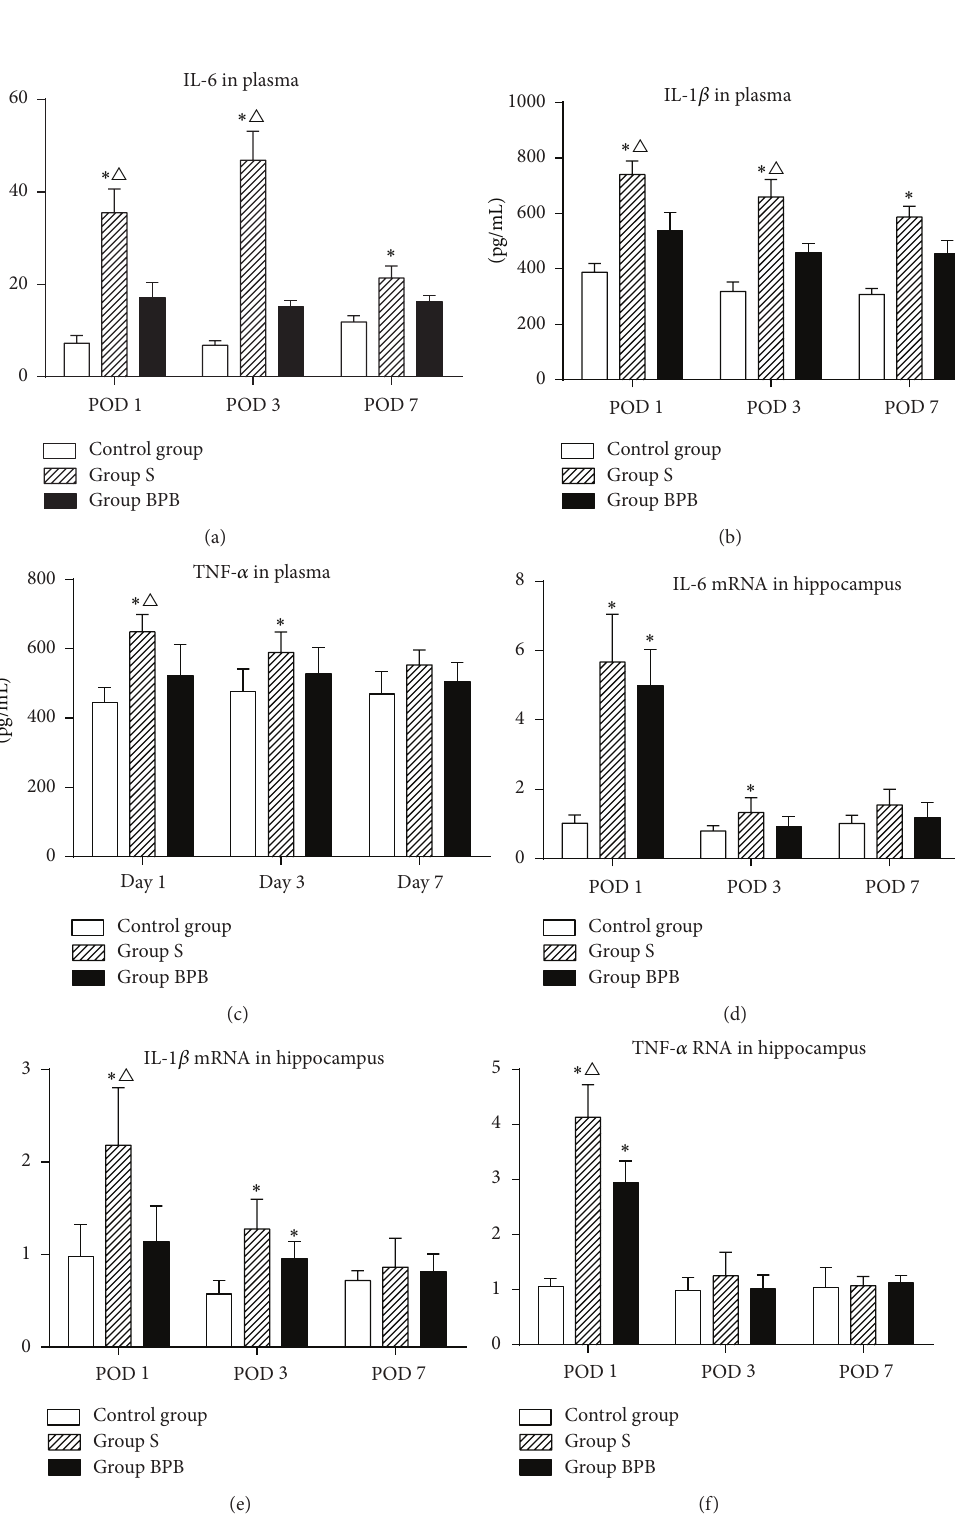
Figure 1: The levels of proinflammatory cytokines in plasma and in hippocampus. Each bar represents mean ± SEM ( 𝑛 = 6 in each group). ∗ 𝑃 < 0.05 versus control group, 󳵻 𝑃 < 0.05 versus group BPB. POD = postoperative